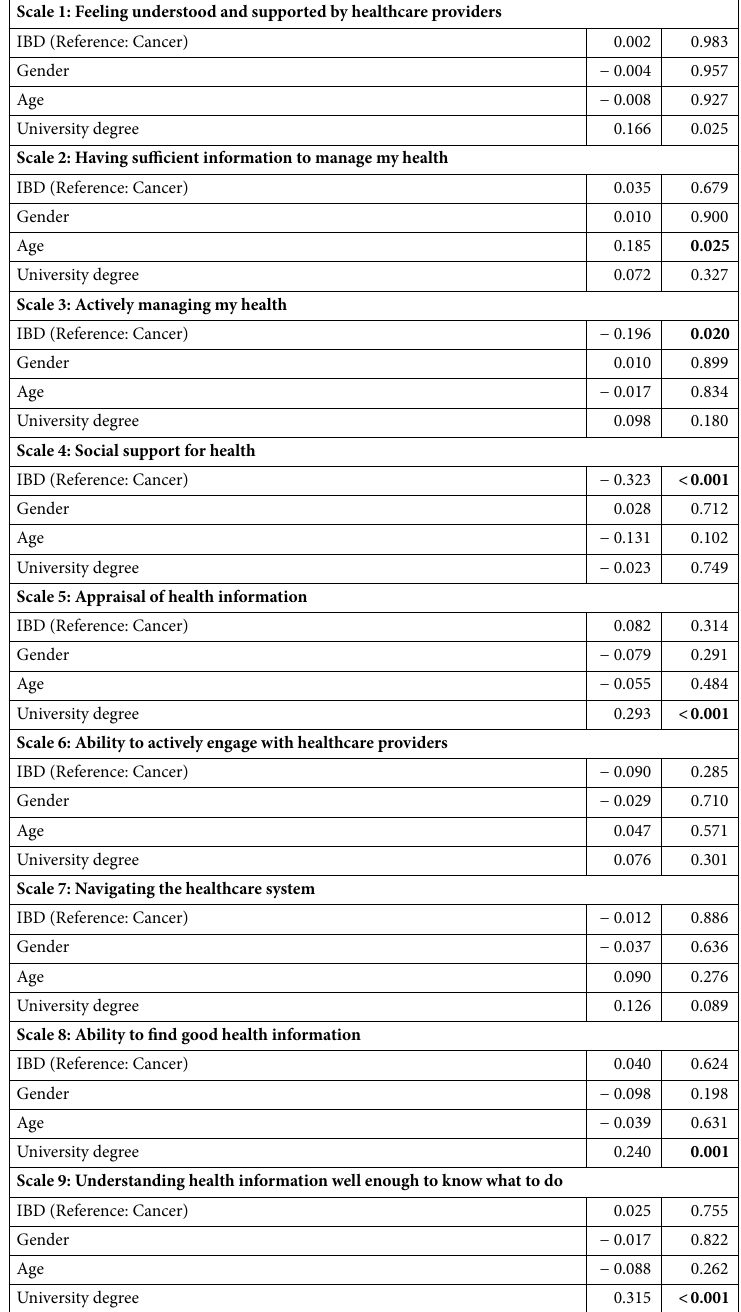
Table 4. Multivariable linear regression analyses of each subscale of the HLQ comparing patients with cancer and inflammatory bowel disease (IBD). Significant values are in [bold]. Cancer was coded as 1 and IBD was coded as 2. Gender: men were coded as 1 and women as 2. University degree was coded as 1 and no university degree was coded as